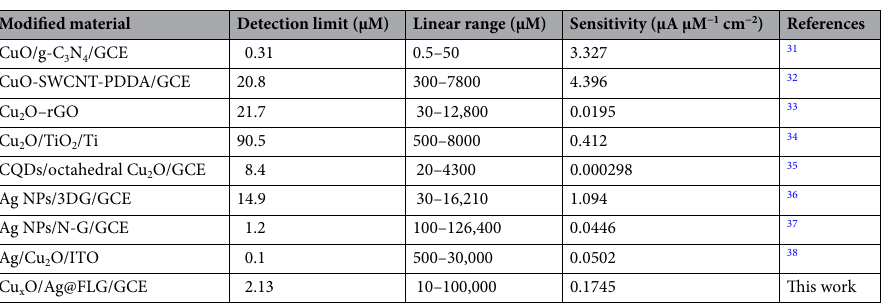
Table 2. Comparison of H 2 O 2 sensors related to CuO, Cu 2 O and Ag in different literature.